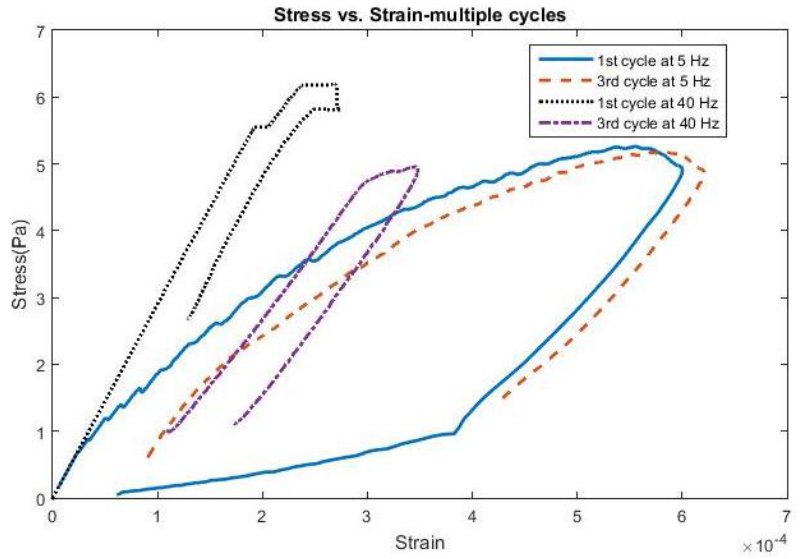
Figure 8. Stress vs. Strain for 4 microns comparing first 3 cycles of motion using 200 kPa Young’s Modulus.